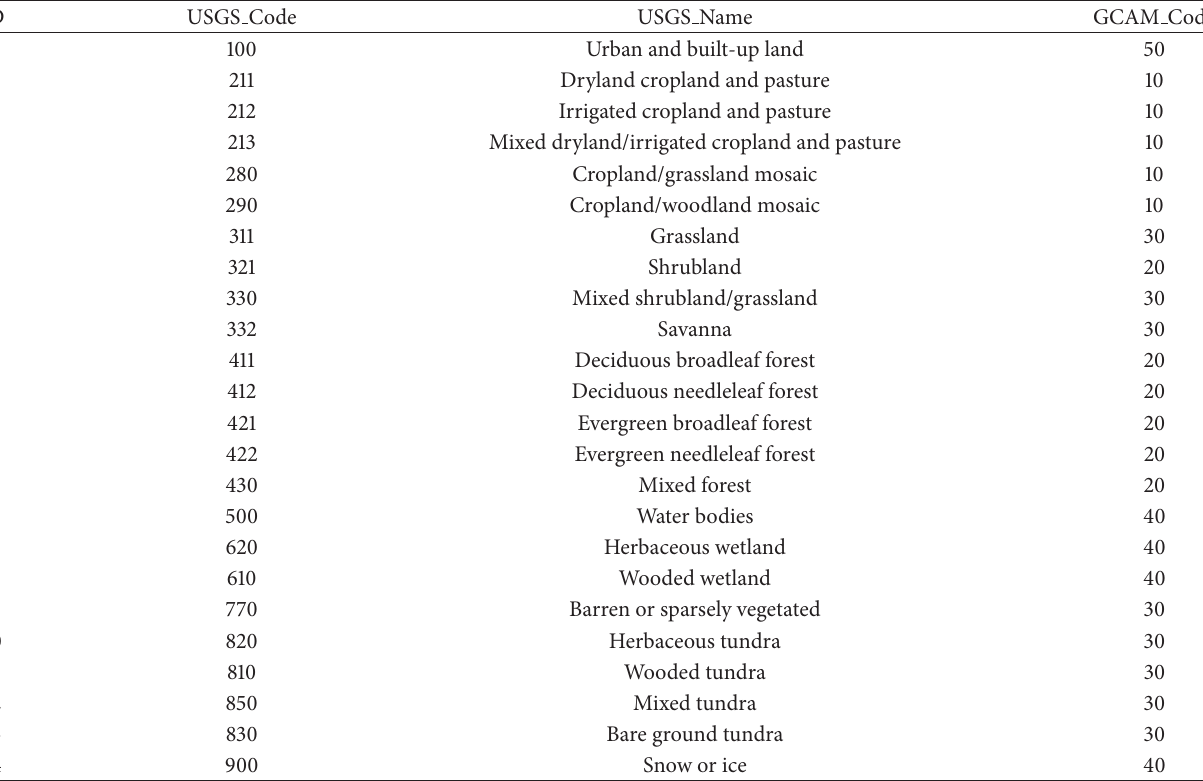
Table 2: Mapping table of land use/cover types of USGS and GCAM classification